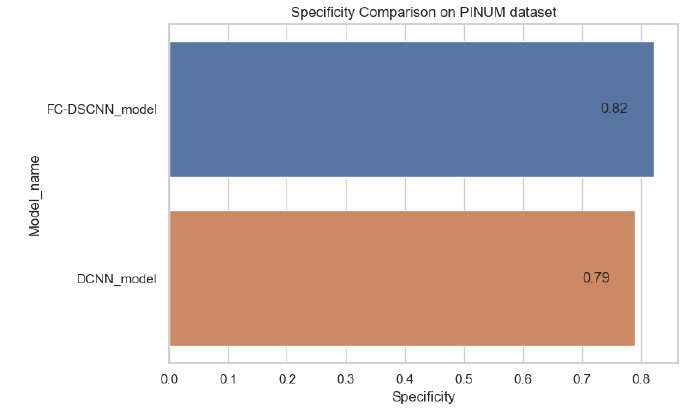
Figure 14. Specificity comparison on the PINUM dataset.